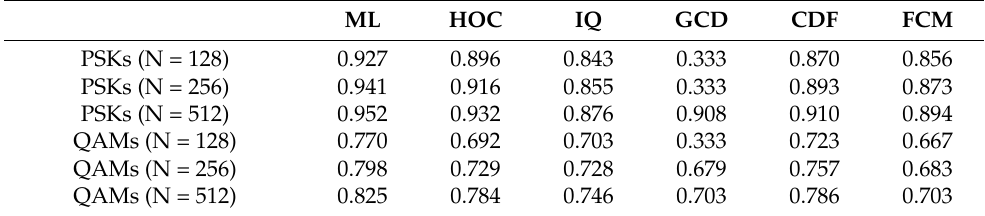
Table 6. Average probability of correct classification of different features under flat-fading channel at N = 128, 256, and